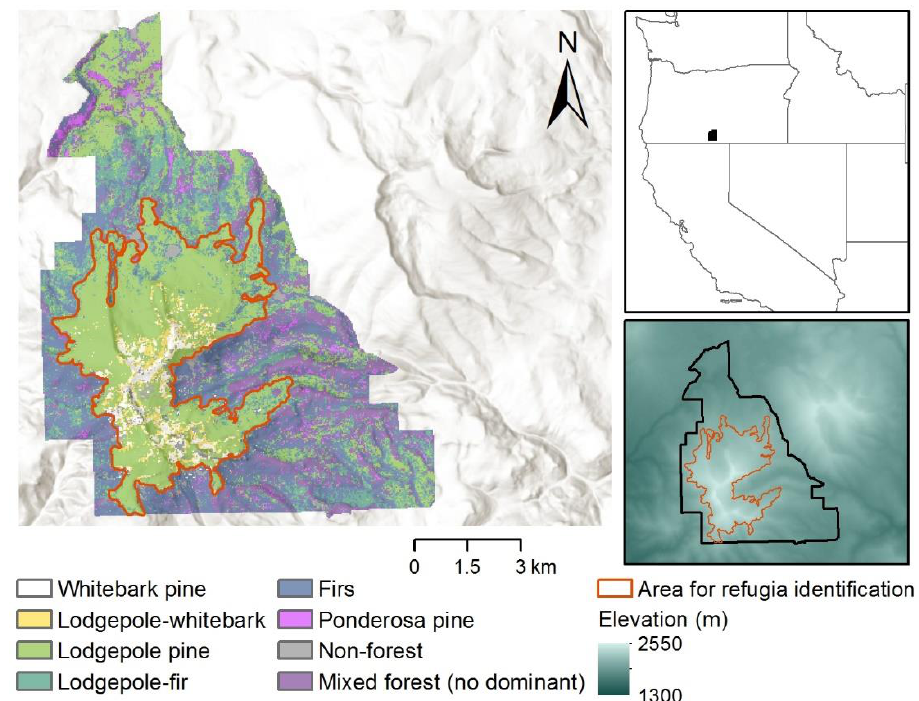
Figure 2. Location of the Gearhart Mountain Wilderness study area in southern Oregon, USA. Refugia from drought and a mountain pine beetle outbreak were identified within lodgepole pine, lodgepole pine–whitebark pine, and whitebark pine forests.